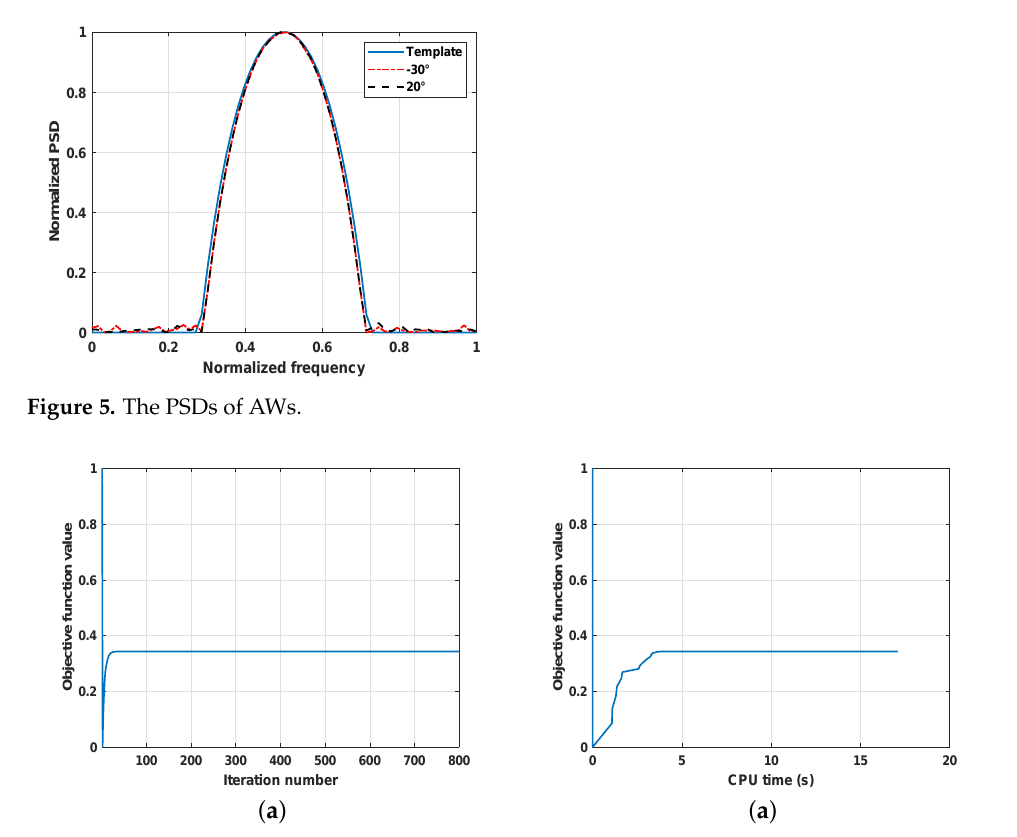
Figure 6. The convergence performance of the proposed algorithm. ( a ) Objective function value vs. iteration number. ( b ) Objective function value vs. CPU